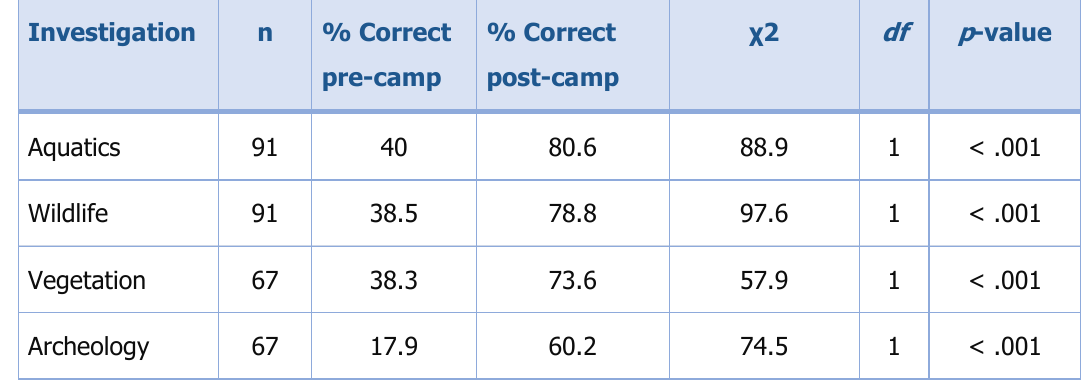
Table 3. Comparison of the Frequency of Correct Answers Before and After CCNRC,